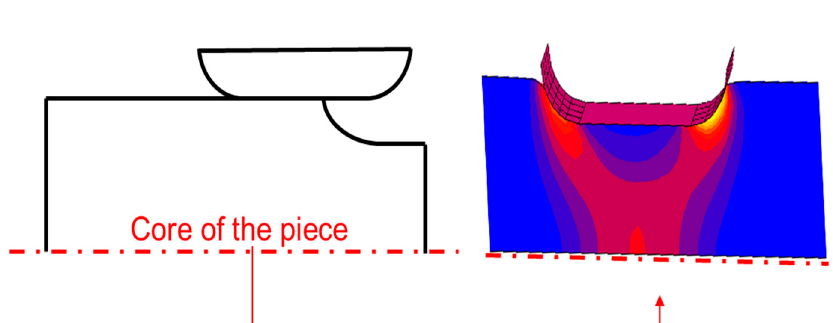
Figure 4. Schematic representation of forged piece simulated; results have been token at the core of the piece in terms of plastic strain as a function of the length.